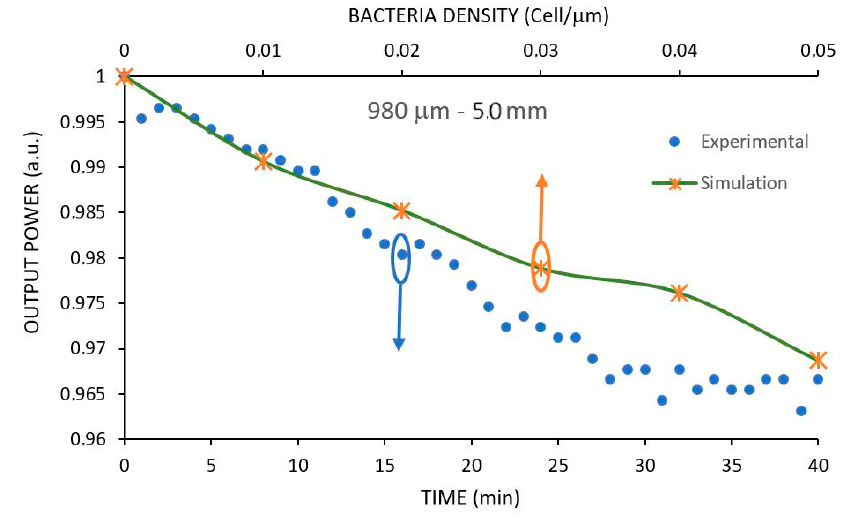
Figure 10. Comparison of the experimental results of the 980 µm–5.0 mm of U-Shaped sensor for E. coli with simulated results.